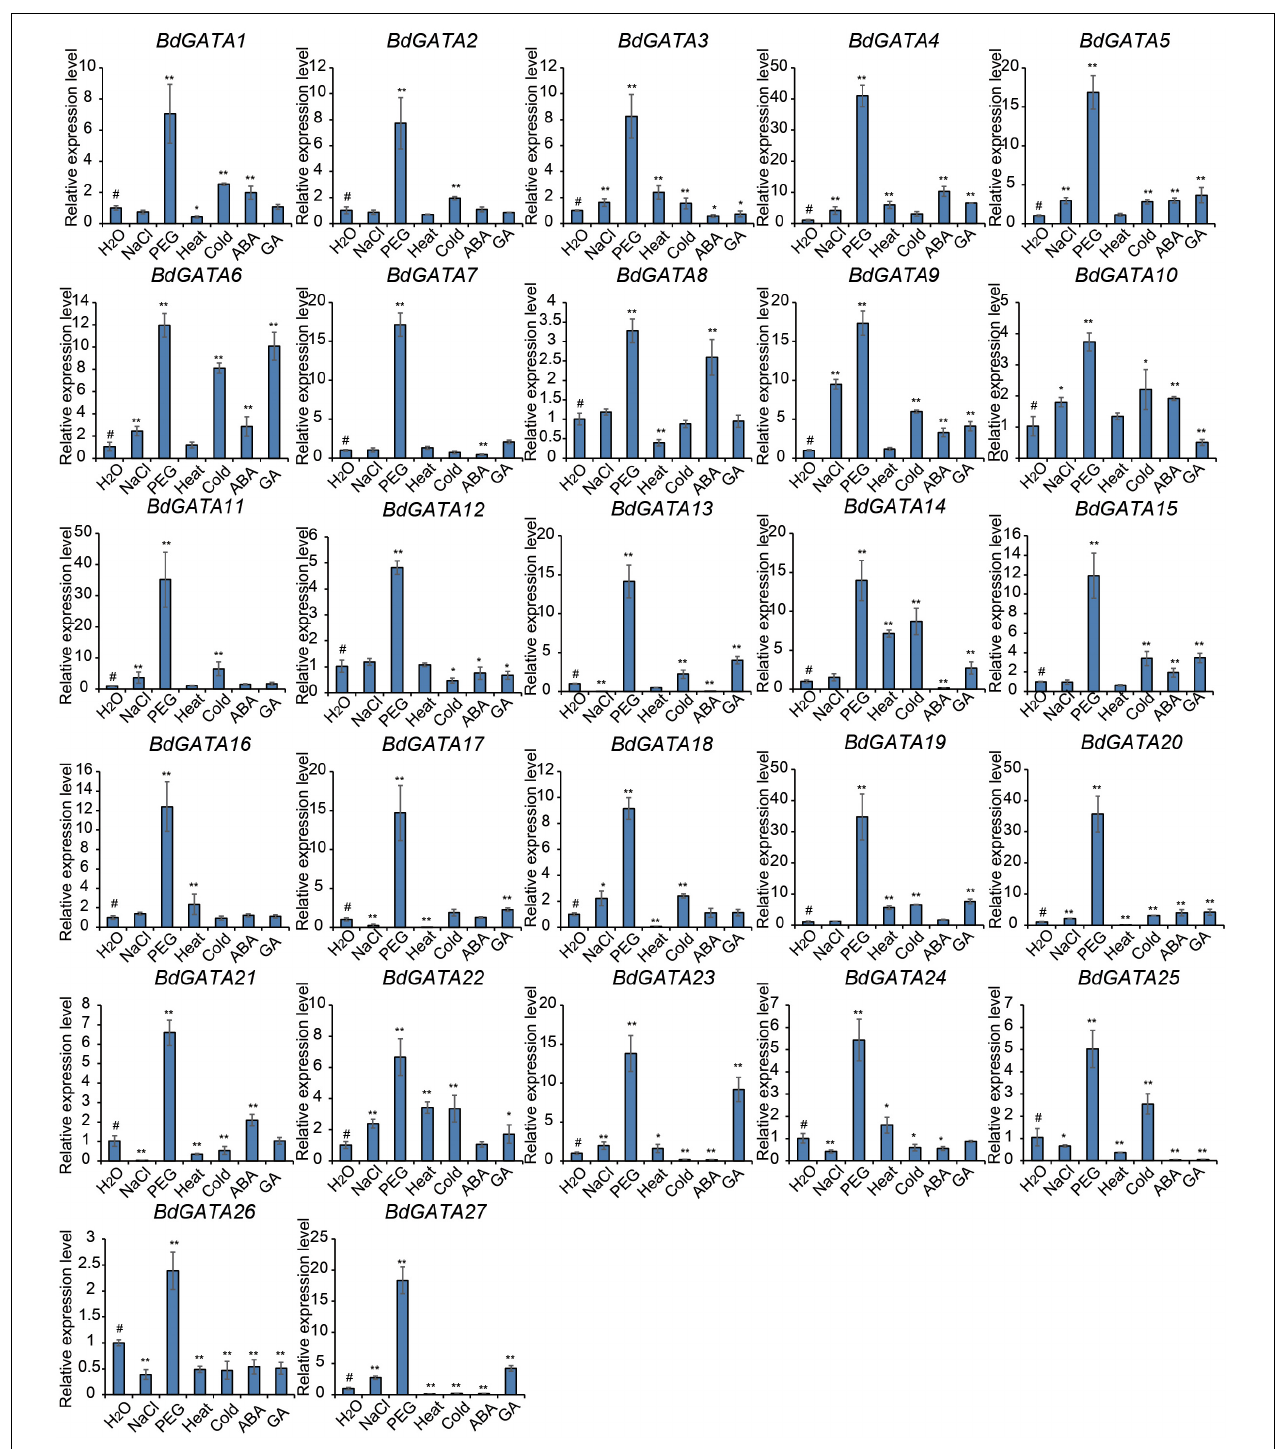
FIGURE 5 | Expression patterns of BdGATAs under abiotic stresses. The ordinate indicates the relative expression level; and the horizontal axis represents different abiotic stresses, including salt (200 mM NaCl), drought (20% PEG), heat (45 ◦ C), cold (4 ◦ C), ABA (200 µ M), and GA (10 µ M) for 2 h in hydroponic culture. The results were normalized against the expression of BdGAPDH as an internal control. Values are means ± SD ( n = 3). Asterisks represent statistically significant differences between the indicated samples. H 2 O (#) is used as control for each treatment. Student’s t -test: * P ≤ 0.05 and ** P ≤ 0.01.